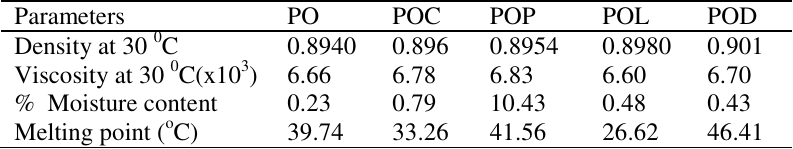
Table 1. Physical parameters of the